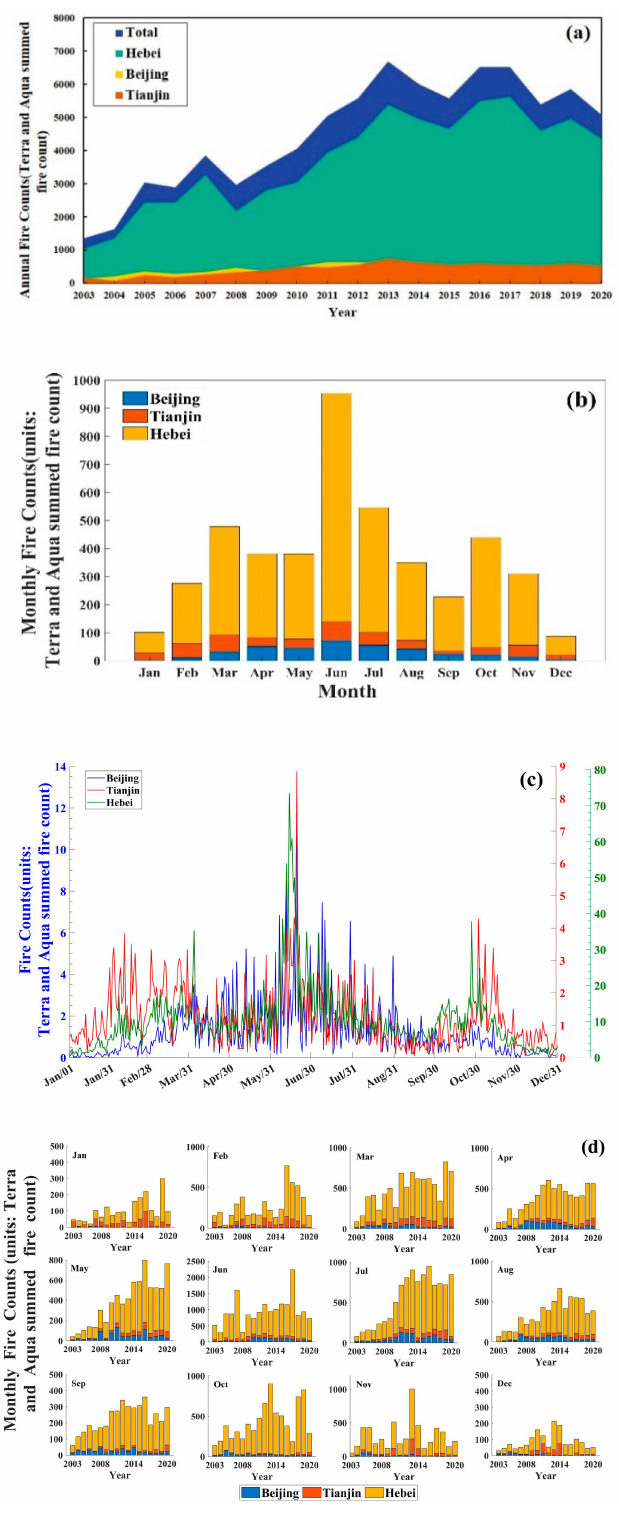
Figure 3. The annual ( a ), monthly ( b , d ), and daily ( c ) variation of fire counts from GFED4 in different provinces and BTH from 2003 to 2020. BTH represents the provinces of Beijing, Tianjin, and Hebei,